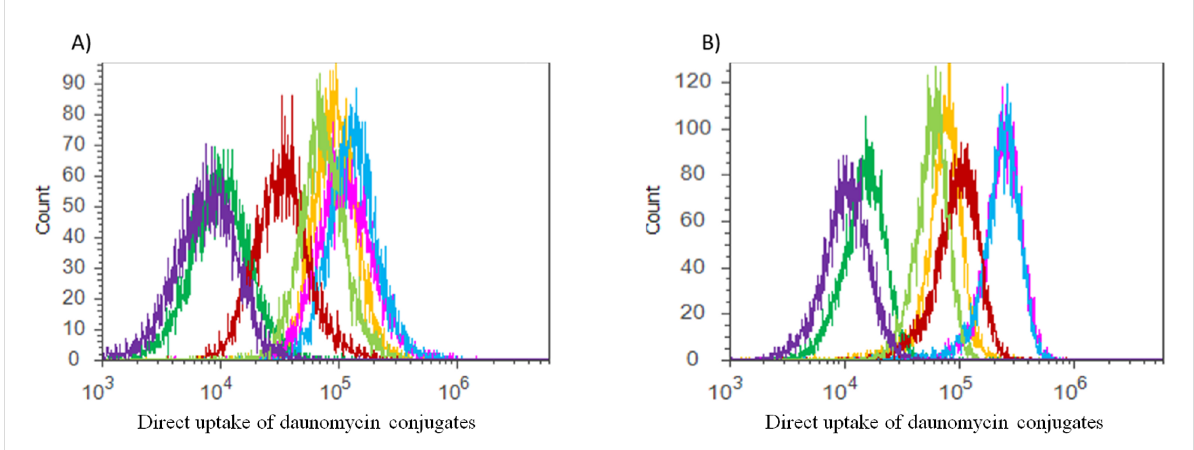
Figure 2: (A) HT1080 and (B) HT-29 cells. Uptake of conjugate 1 (light green); 2 (red); 3 (light blue); 4 (pink); 5 (green); K (yellow). Empty control with purple